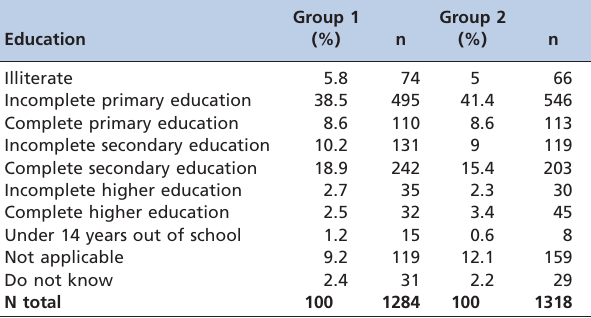
Table 2 - Characterization of the population with respect to